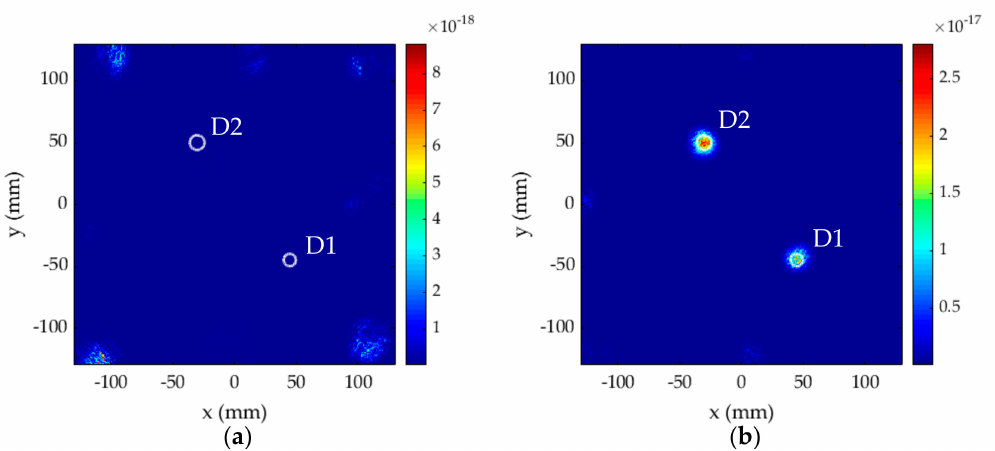
Figure 25. Baseline-free aggregate damage image for the multiple damage scenario in pulse–echo configuration with SNR 30 dB: ( a ) without time compensation; ( b ) with time